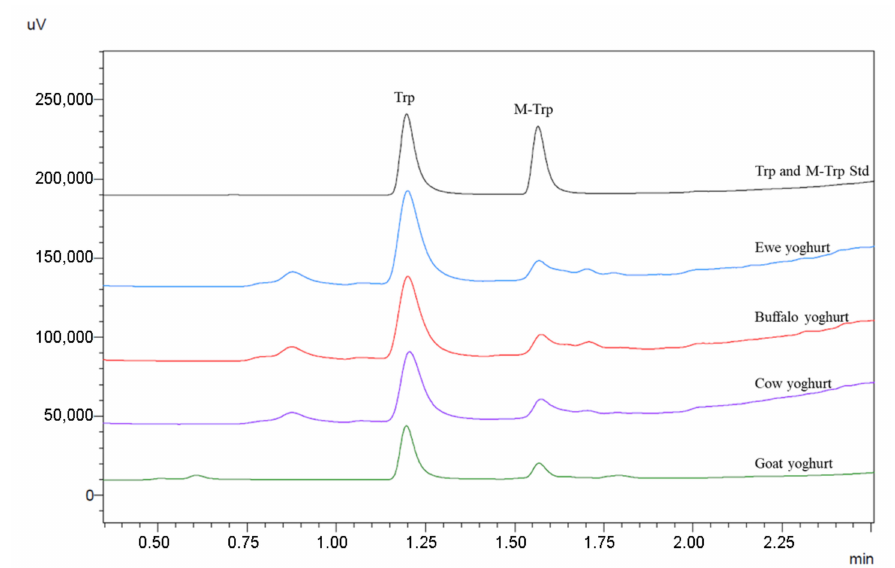
Figure 1. Chromatographic profile of a TRP and M-TRP standard solution and yoghurt samples extracts, according to the chromatographic conditions reported in Section